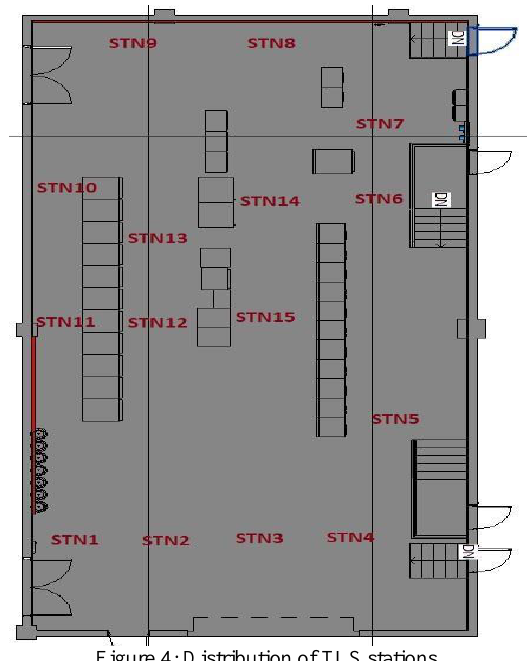
Figure 4: Distribution of TLS